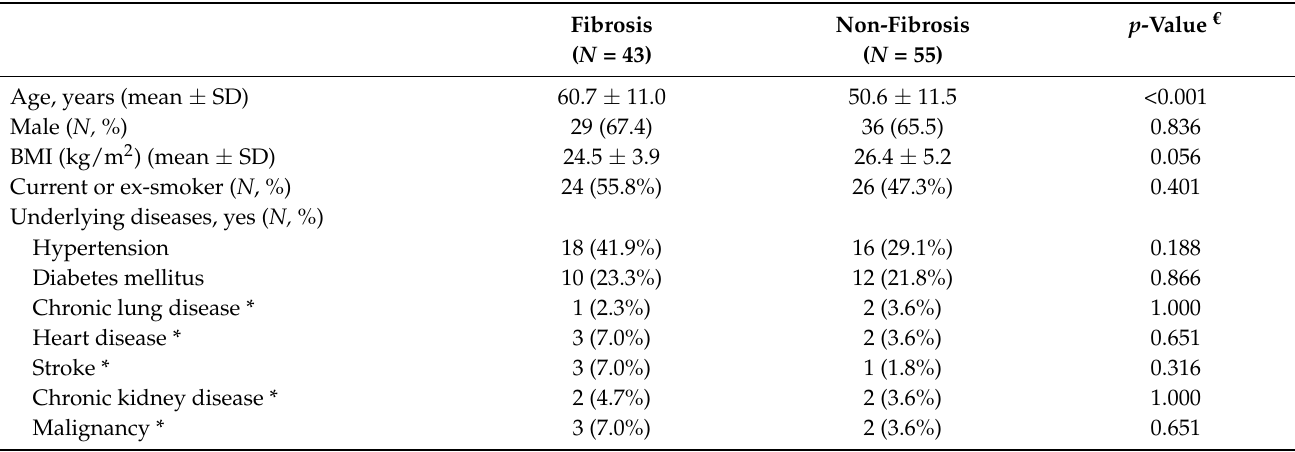
Table 1. Clinical characteristics of the study